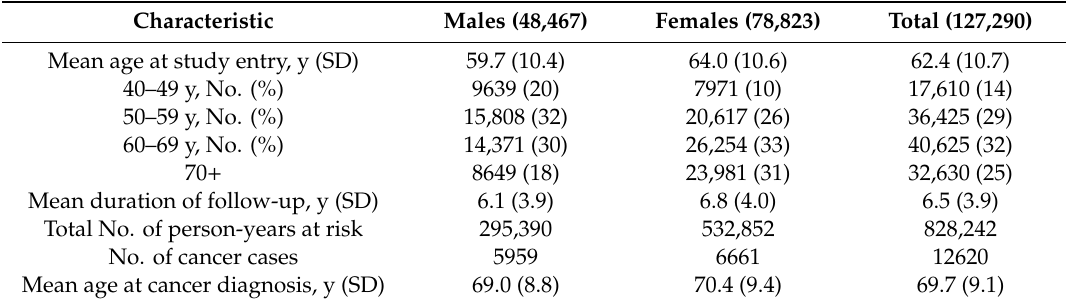
Table 1. Characteristics of the study